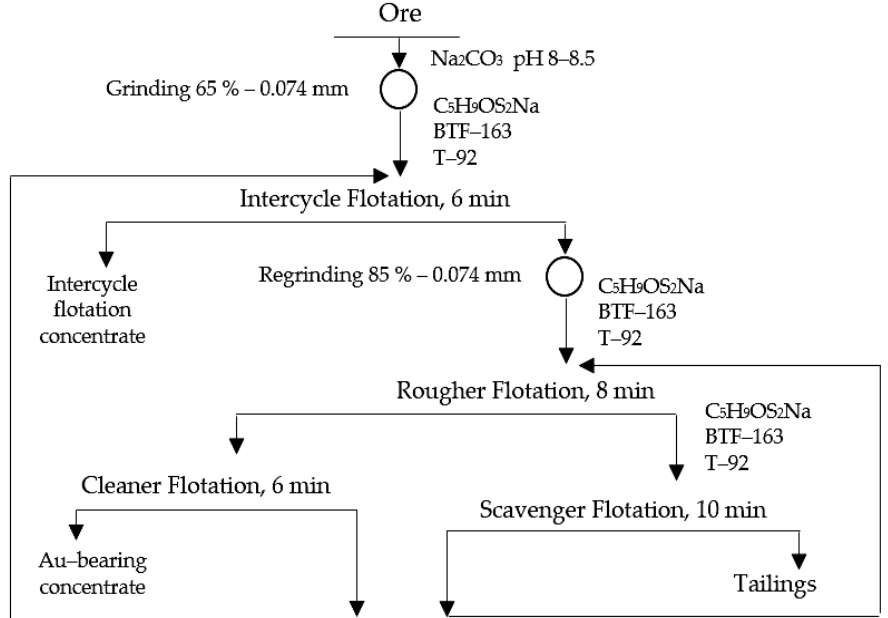
Figure 3. Scheme of gold-bearing ore flotation.